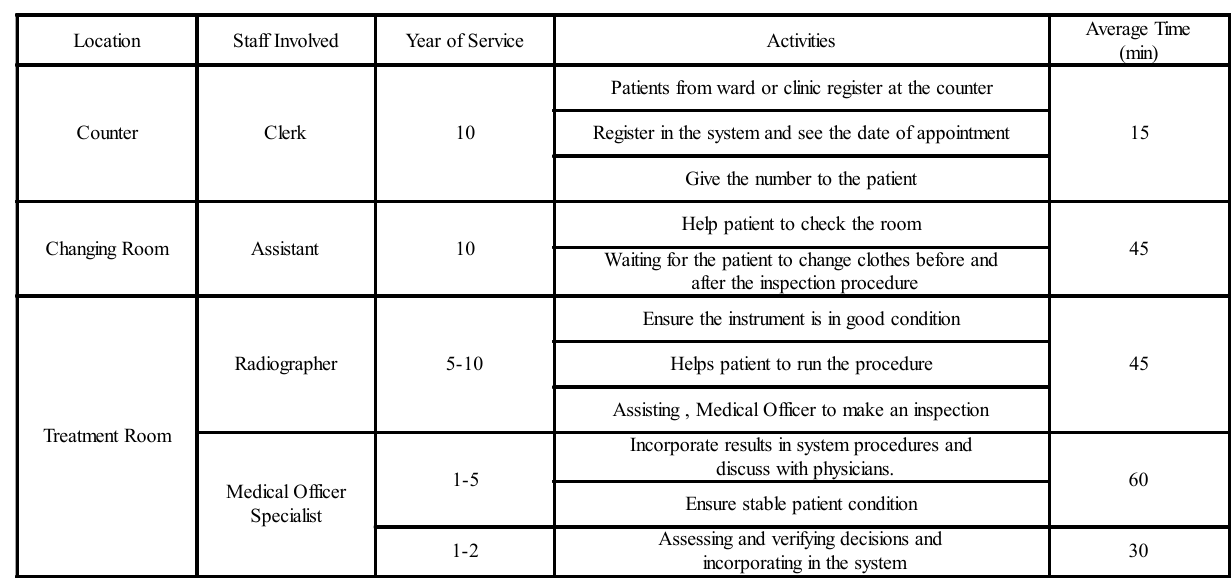
TABLE 2. THE PROCESS OF MRI